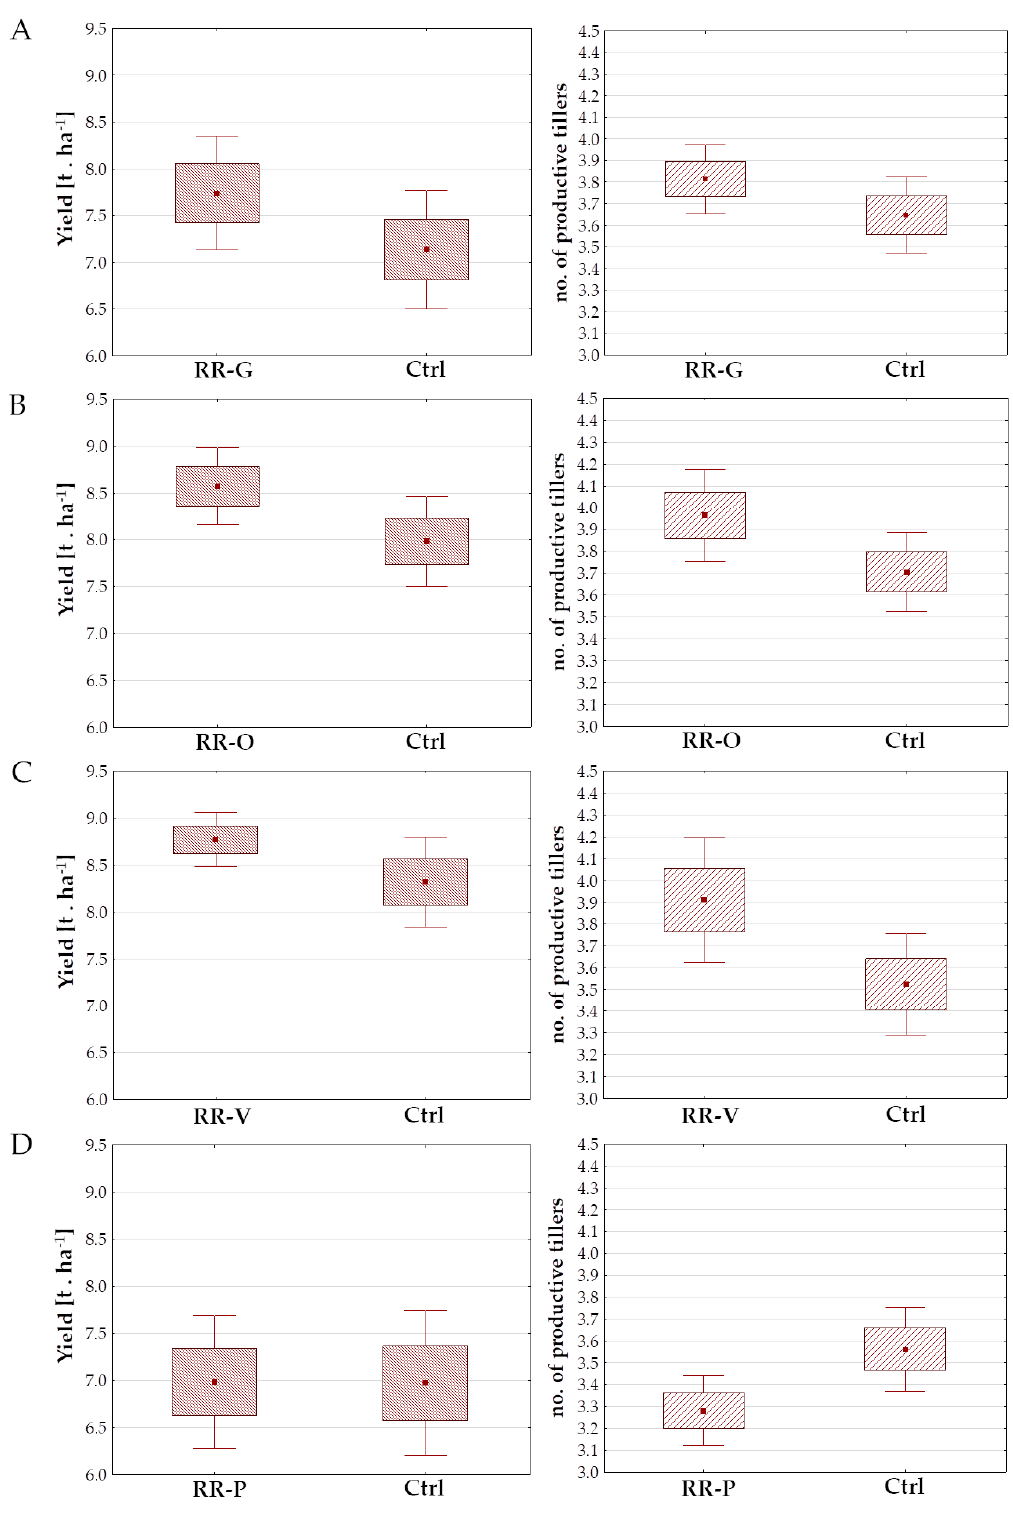
Figure 3. Results (grain yield in t · ha − 1 and number of productive tillers) from field plot experiments with spring barley, compared to the control. ( A ) RR-P application as a seed coating, ( B ) RR-G, ( C ) RR-O, and ( D ) RR-V applied as foliar spraying at the tillering stage (BBCH 21–25).